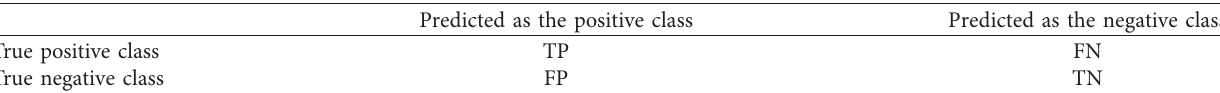
Table 1: Confusion matrix.